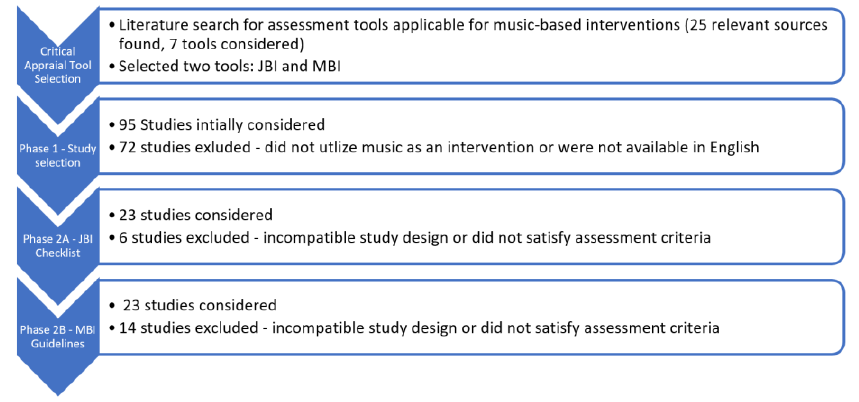
Figure 1. Flowchart of methodological process.